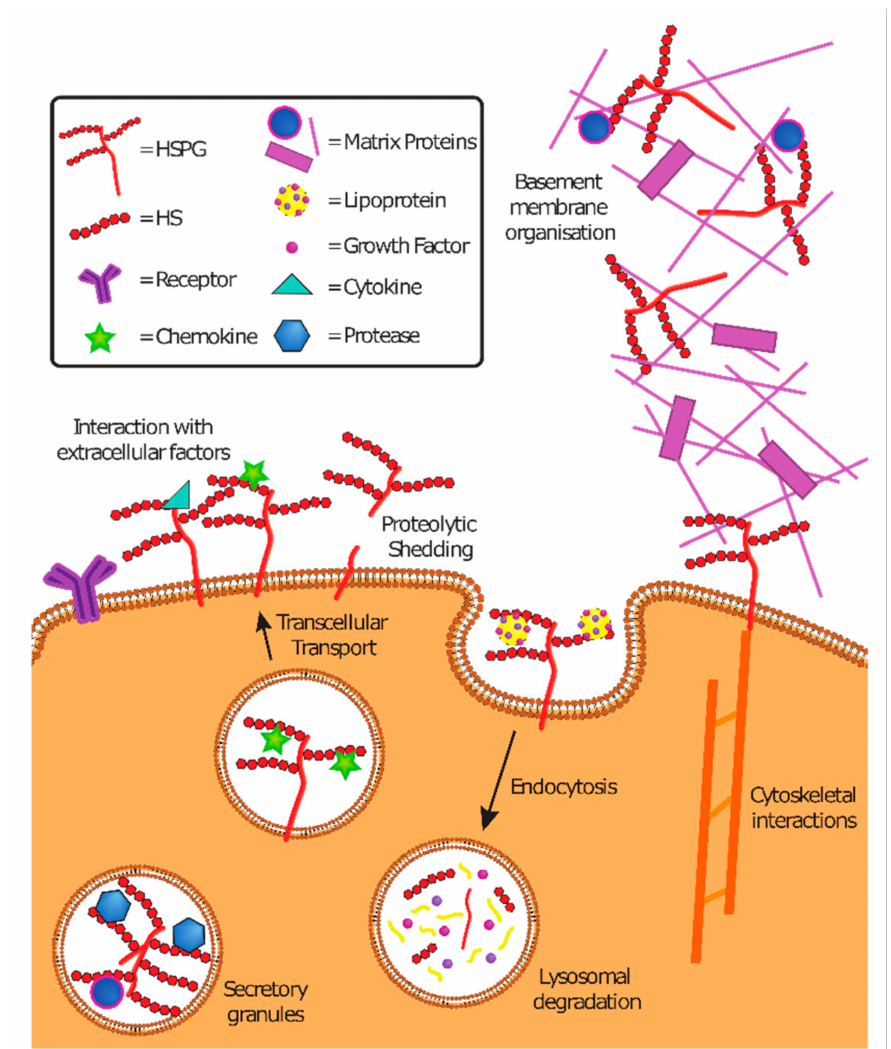
Figure 3. Functions of HSPG. HSPG in the ECM contribute to basement membrane organization. HSPG expressed on the cells mediate interactions with extracellular factors, play a role in endocytosis and lysosomal degradation and transcellular transport, and can be shed in response to stress after proteolytic cleavage. Adapted with permission from